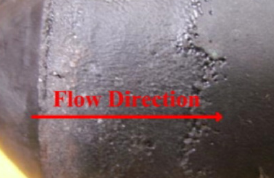
Figure 1. Damage of the valve plug results from cavitation erosion [21]-Copyright 2016, Elsevier.